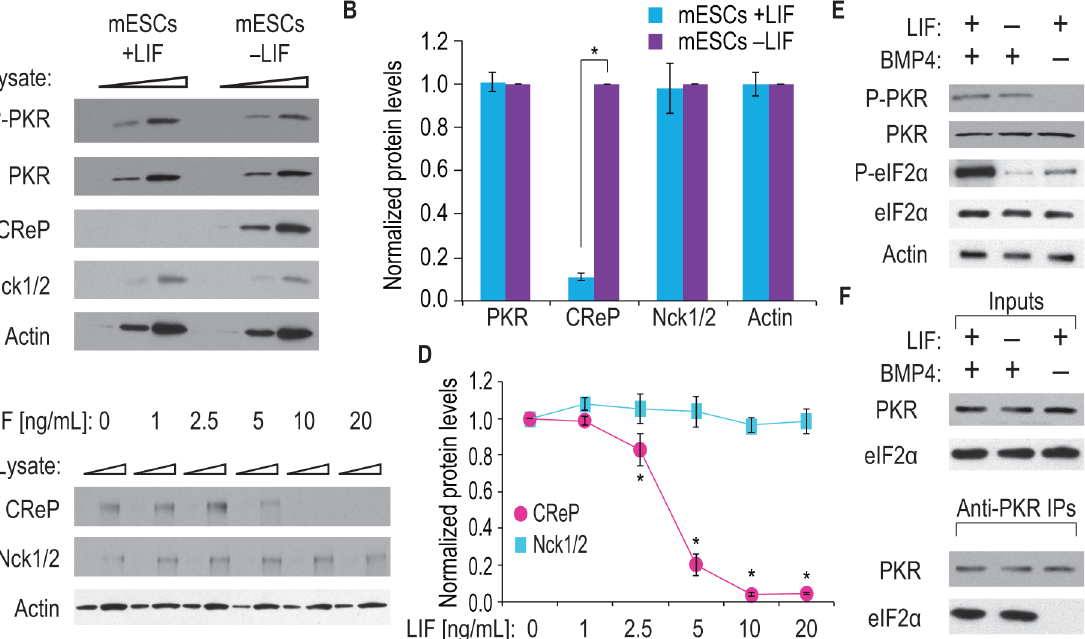
Fig 2. LIF and BMP4 enhance eIF2 α phosphorylation. (A) mESCs were cultured for 24 h either with LIF (mESCs +LIF) or without LIF (mESCs – LIF). Increasing amounts of cell lysate (indicated by triangles) were separated by SDS-PAGE and proteins visualized by western blot. PKR was uniformly present in both samples, with no difference in active PKR levels (P-PKR). CReP levels were low in mESCs cultured with LIF and upregulated in mESCs cultured without LIF. Nck1/2 levels were uniform. Actin is a loading control. (B) Three biological replicates were prepared as in (A) and quantitated. Data were then normalized to values from mESCs grown without LIF. CReP levels increased when LIF was withdrawn, whereas PKR and Nck1/2 levels were unchanged. Error bars represent s.d. ( * , p < 0.01 compared to mESCs – LIF samples). (C) mESCs were cultured for 24 h with increasing concentrations of LIF (10 ng/mL is standard). Increasing amounts of cell lysate (indicated by triangles) were separated by SDS-PAGE and western blotted for CReP, Nck1/2 and Actin. LIF downregulates CReP, but not Nck1/2 or Actin. (D) Three biological replicates were prepared as in (C) and quantitated. Data were normalized to values from mESCs cultured without LIF. Increasing LIF decreases CReP levels, but does not affect Nck1/2. Error bars represent s.d. ( * , p < 0.01 compared to 0 ng/mL LIF samples). (E) mESCs were cultured for 24 h with or without LIF and with or without BMP4 (indicated by + and – signs). Higher levels of active P-PKR were seen with BMP4, less with BMP4 removed. P-eIF2 α levels were highest in mESCs grown with both LIF and BMP4. Total PKR and eIF2 α levels were constant as was Actin, probed as a loading control. (F) The presence of active P-PKR was assayed by co-IP for PKR and its substrate eIF2 α . mESCs were cultured as in (E); Western blots visualized PKR and eIF2 α in total cell lysates (Input; upper panels) or PKR IPs (Anti-PKR IP; lower panels). eIF2 α is present in all inputs (upper panel), but eIF2 α co-IPs with PKR only in cells treated with BMP4 (lower